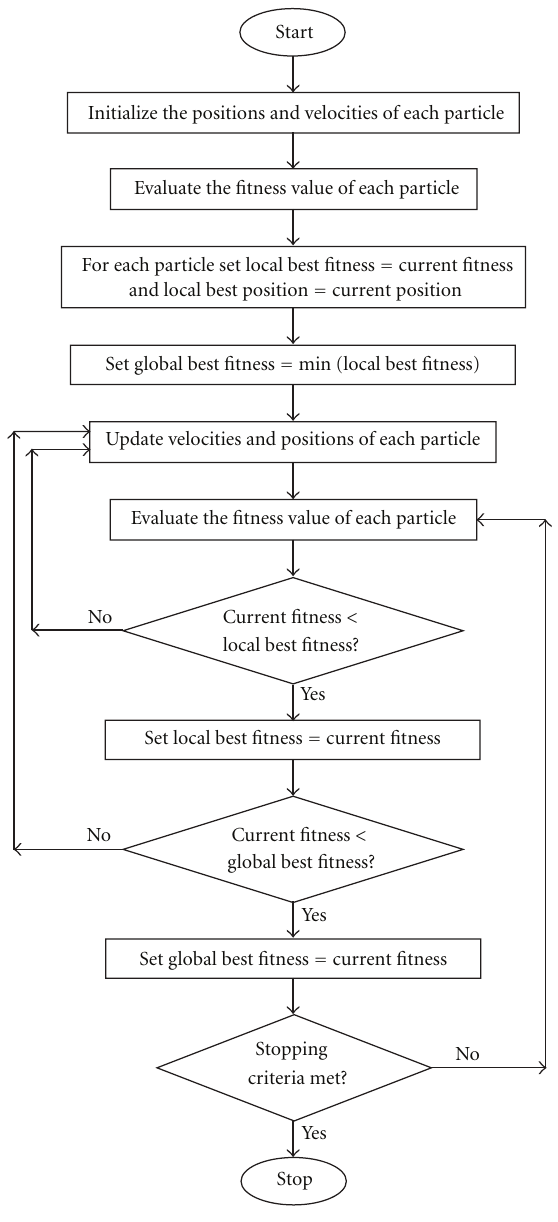
Figure 3: Flowchart of PSO